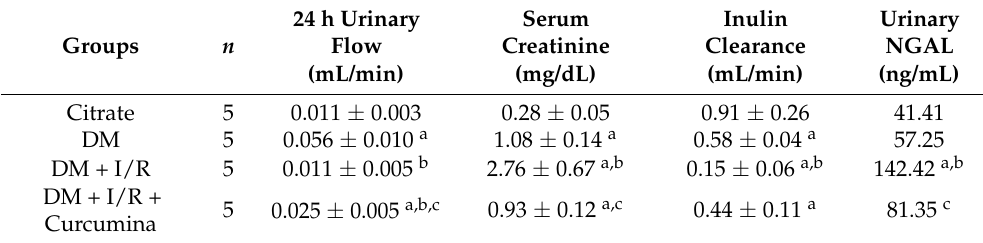
Table 5. Renal function.